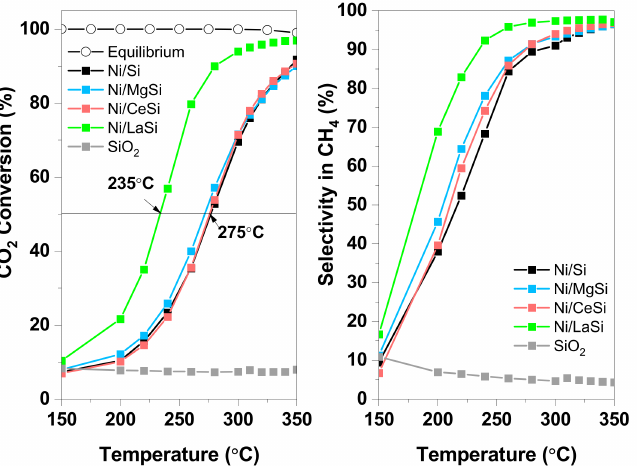
Figure 7. CO 2 conversion and CH 4 selectivity for silica supported Ni catalysts in TPRea experiments (0.1 g catalyst, temperature rate 2 ◦ C/min, p = 1 atm, total gas flow 31 mL/min, C CO2 = 6.6%, CO 2 :H 2 = 1:5.2; GHSV = 4650 h − 1 ) (left: CO 2 conversion rate; right: CH 4 conversion